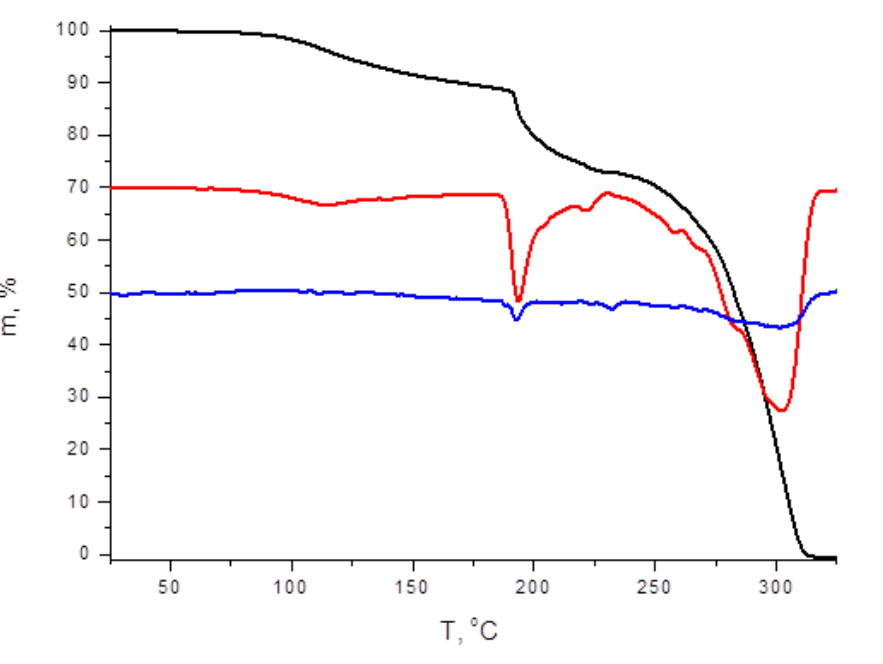
Figure 5. TG, DTG, and DTA curves of 2 .